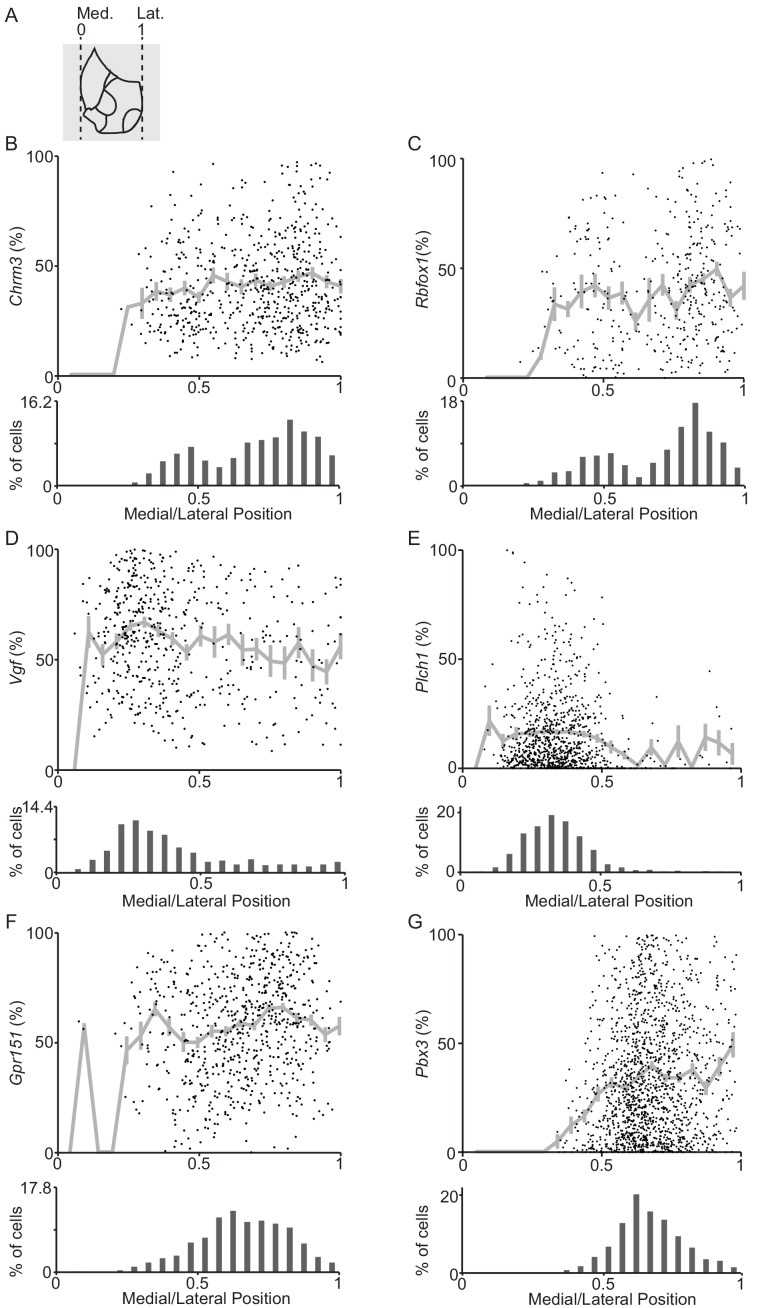
Spatial distribution of gene expression patterns along the medial/lateral axis for selected LHb DEGs.(A) Illustration of LHb subregions depicting the medial (0) and lateral (1) edges of the habenula used to describe the spatial distribution of gene expression. (B,C) (Top) Expression levels of Chrm3 (B) or Rbfox1 (C) in individual LHb neurons along the medial/lateral axis. Gray line is the mean expression level and vertical bars are the SEM for each bin (bin size 0.05). (Bottom) Histogram showing the distribution of the density of Chrm3+ (B) or Rbfox1+ (C) neurons along the medial lateral axis of LHb (Chrm3: n = 616 cells/3 mice, Rbfox1: n = 392 cells/3 mice). (D,E) (Top) Expression levels of Vgf (D) or Plch1 (E) in individual LHb neurons along the medial/lateral axis. Gray line is the mean expression level and vertical bars are the SEM for each bin (bin size 0.05). (Bottom) Histogram showing the distribution of the density of Vgf+ (D) or Plch1+ (E) neurons along the medial lateral axis of LHb (Vgf: n = 535 cells/3 mice, Plch1: n = 961 cells/3 mice). (F,G) (Top) Expression levels of Gpr151 (F) or Pbx3 (G) in individual LHb neurons along the medial/lateral axis. Gray line is the mean expression level and vertical bars are the SEM for each bin (bin size 0.05). (Bottom) Histogram showing the distribution of the density of Gpr151+ (F) or Pbx3+ (G) neurons along the medial lateral axis of LHb (Gpr151: n = 1122 cells/3 mice, Pbx3: n = 1507 cells/3 mice).